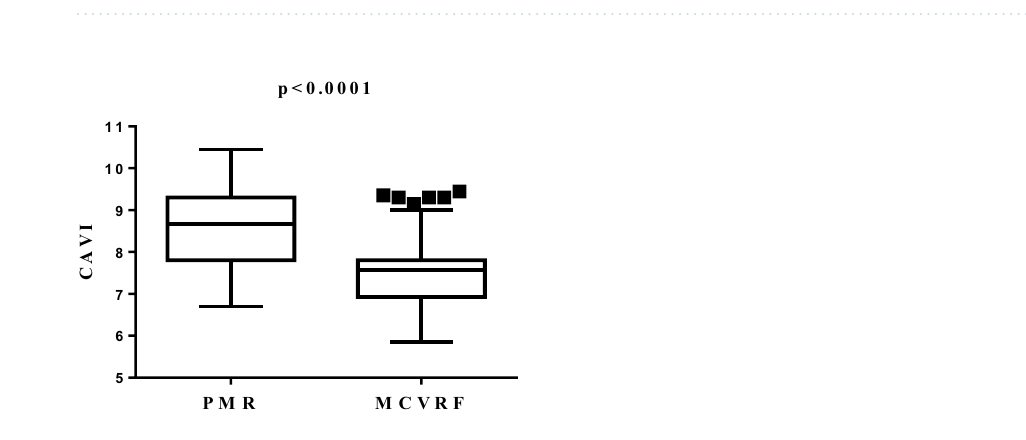
Figure 1. IMT values (right/left side mean values) in patients with PMR (n = 48) and MCVRF controls (n = 56). Data are shown as Tukey boxplots; lines represent the median level with 25th–75th percentile. IMT intima- media thickness, PMR polymyalgia rheumatica, MCVRF major cardiovascular risk factors.